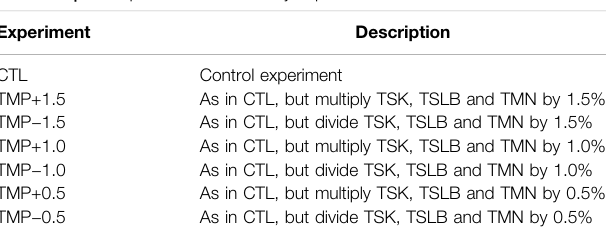
TABLE 2 | Description of the sensitivity